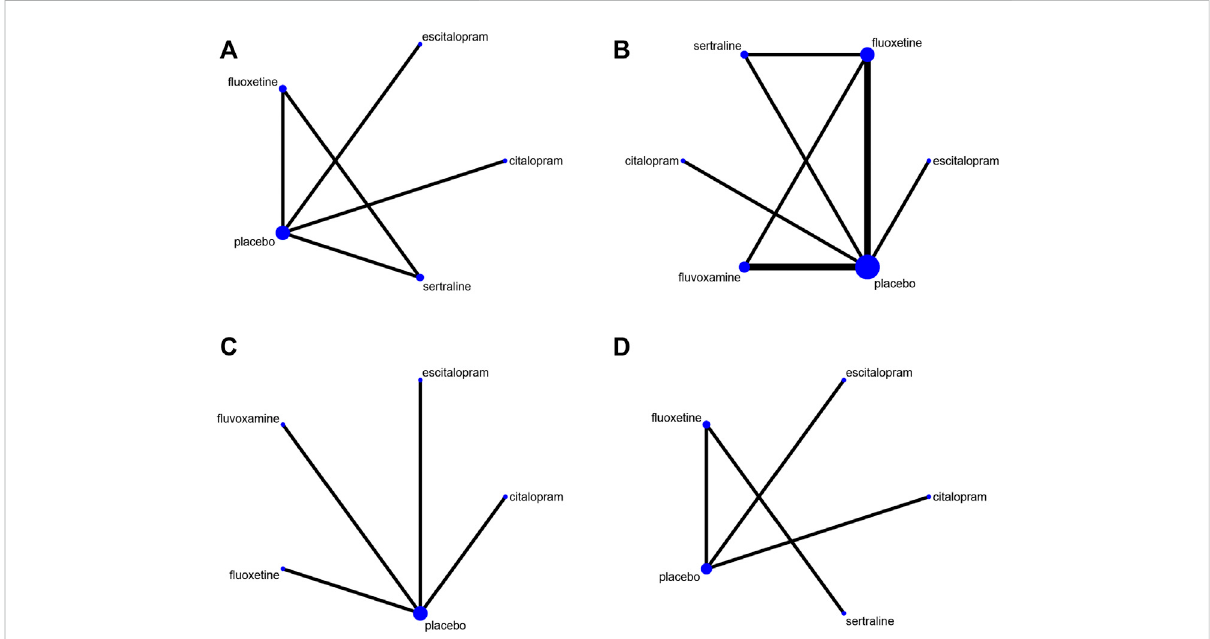
FIGURE 2 The network plots. (A) It was the network plot about the effect of antidepressants on reducing binge frequency of BED patients; (B) Dropout rate; (C) HAMD score; (D)